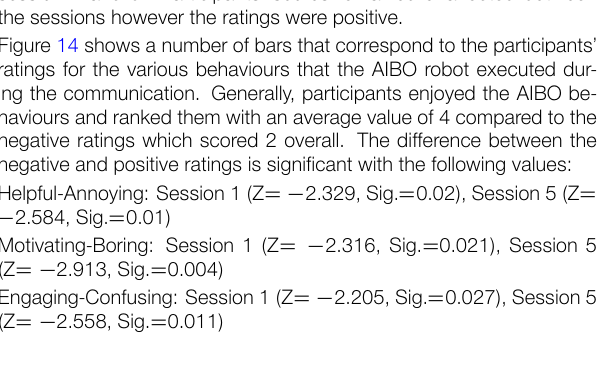
session 1 and 5. Participants’ scores remained unaffected between the sessions however the ratings were positive.